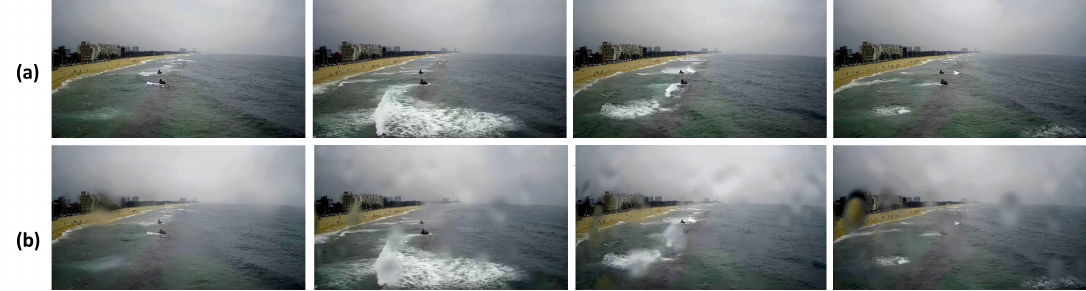
Figure 5. Samples of our Anmok paired dataset : ( a ) images degraded with raindrops and ( b ) their corresponding ground-truth images. The dark pixels at the point where the wave breaks indicate the area where the submerged breakwater is